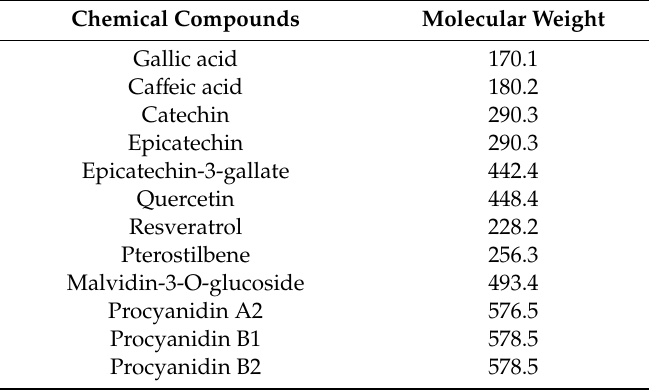
Table 3. Molecular weight of phenolic and polyphenolic compounds from V. vinifera with antifungal activity.